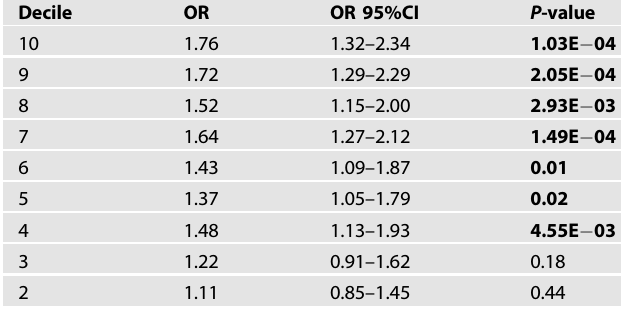
Table 3. Odds ratios when comparing each PRS gene decile with the bottom decile in AA (COGA, SAGE, and YalePenn combined). Decile OR OR